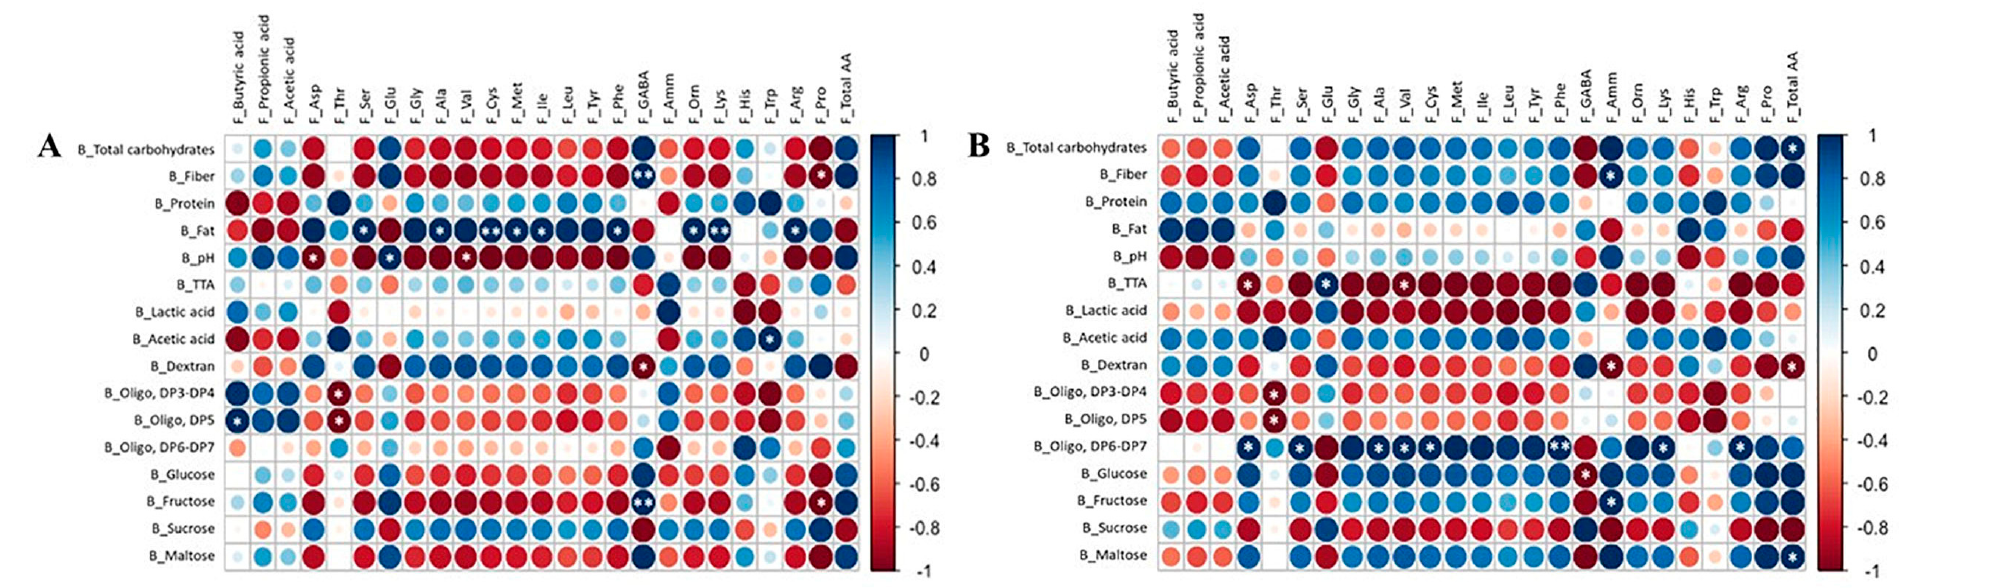
Figure 3. Pearson correlation among EPS+BSG bread (EPS+BB) content of total carbohydrate, dietary fiber, protein, fat, lactic and acetic acids, dextran, MIMO (MOE, DP3–DP7), glucose, fructose, sucrose, maltose, pH, total titratable acidity (TTA) and microbial metabolites (short chain fatty acids and free amino acids) in proximal ( A ) and distal ( B ) colon after one week of treatment period. ( B ) indicates bread variables. F indicates fecal sample variables. The color scale bar indicates a positive (blue) or negative (red) correlation (* p < 0.05, ** p < 0.01).